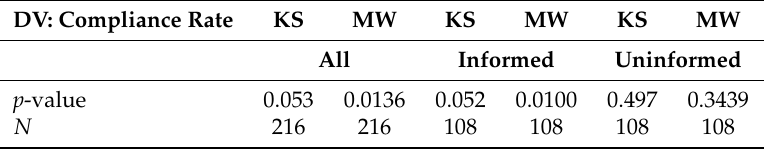
p -values refer to two-sided tests.